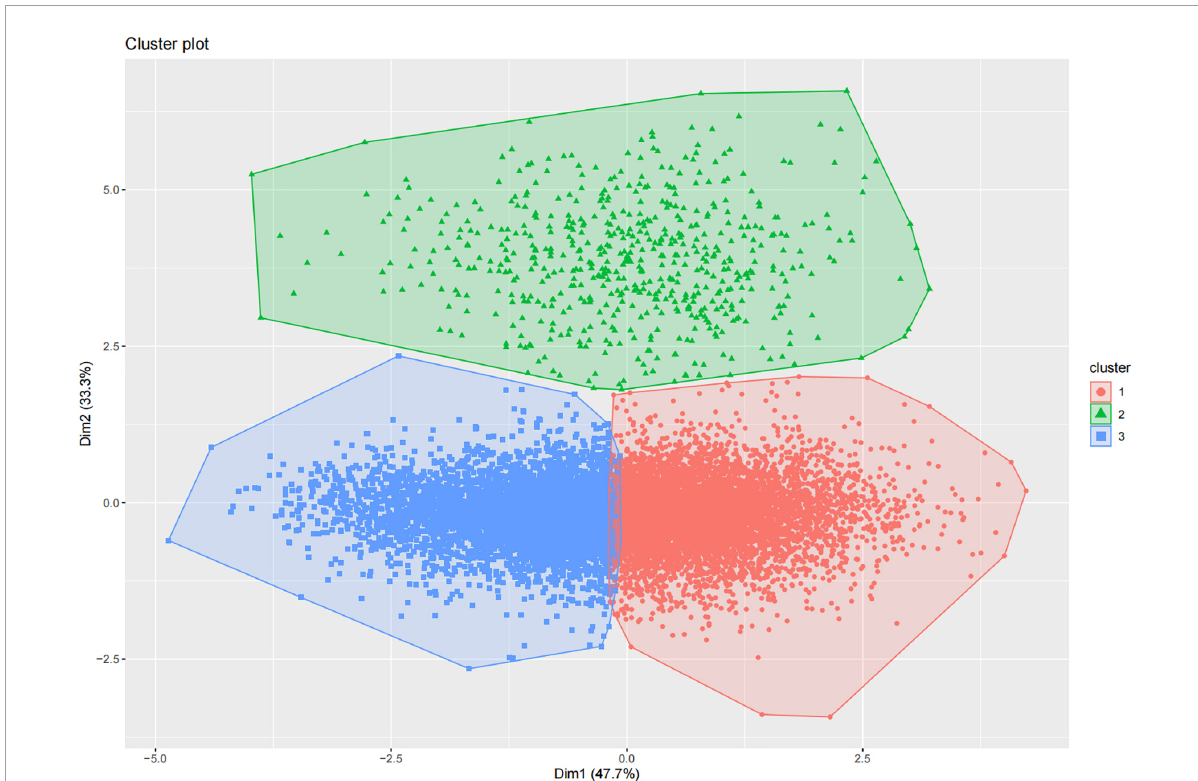
FIGURE2 K-means clustering of participants based on three nutrition- and diet-related scores, and visualization. Red dots indicate cluster 1 [higher healthy eating index (HEI), lower dietary inflammatory index (DII)]; green dots indicate cluster 2 [lower geriatric nutritional risk index (GNRI)]; and blue dots indicate cluster 3 (lower HEI, higher